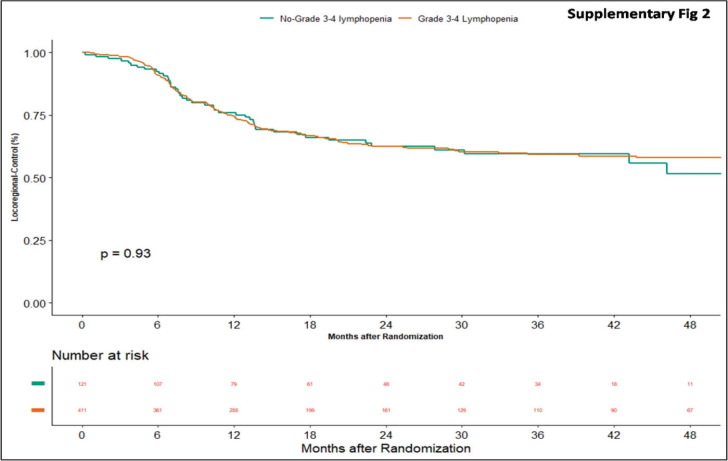
Kaplan–Meier curve showing loco-regional control in grade 3–4 and non-grade 3–4 lymphopenia.